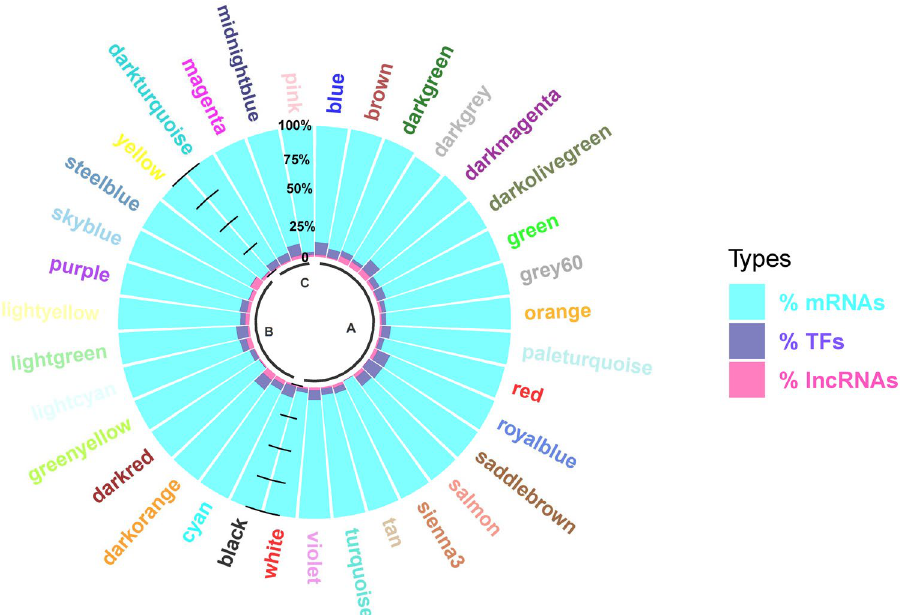
Figure 3. Percentage of mRNAs, lncRNAs and TFs in each Rb-module. Rb-modules were identified across 20 RNA-Seq datasets. A, B and C region indicate non-preserved, semi-preserved and preserved Rb-modules, respectively. As it can be seen, the percentage of mRNAs in all modules is considerably higher than percentage of TFs and lncRNAs. Despite the important regulatory role of TFs and lncRNAs, almost less than 15% of genes in each module is devoted to